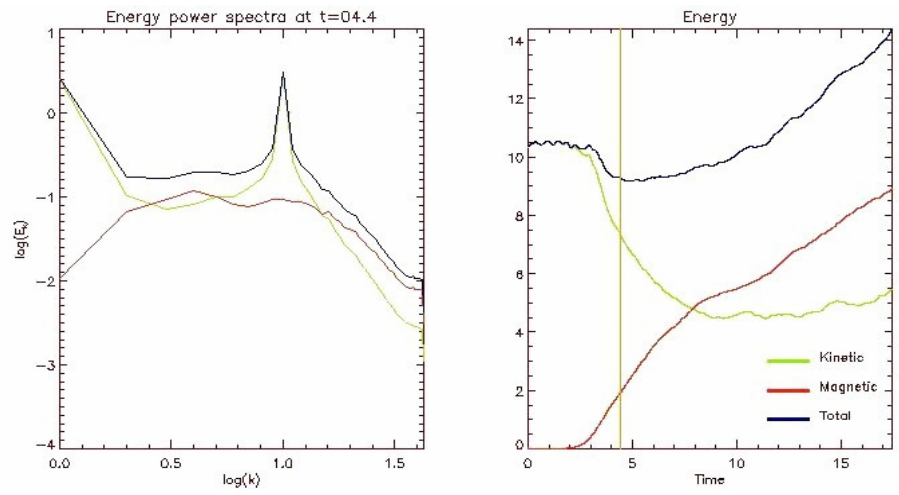
Figure 35: Still from a movie showing A numerical simulation of the incompressible MHD equations in three dimensions, assuming periodic boundary conditions (see details in Mininni et al. , 2003a). The left panel shows the power spectra for kinetic energy (green), magnetic energy (red), and total energy (blue) vs. time. The right panel shows the spatially integrated kinetic, magnetic, and total energies vs. time. The vertical (orange) line indicates the current time. These results correspond to a 128 3 simulation with an external force applied at wave number 𝑘 force = 10 (movie kindly provided by D. G´omez). (To watch the movie, please go to the online version of this review article at http://www.livingreviews.org/ lrsp-2013-2